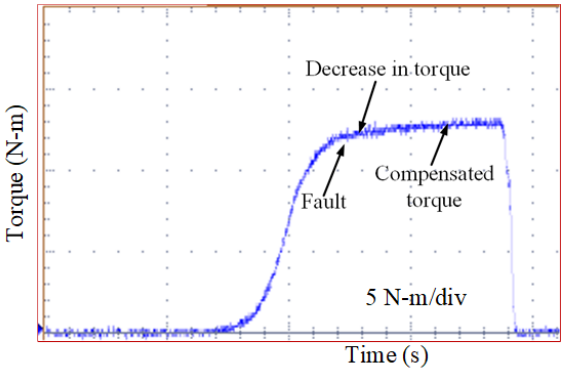
Figure 16. Torque response under fault-tolerant